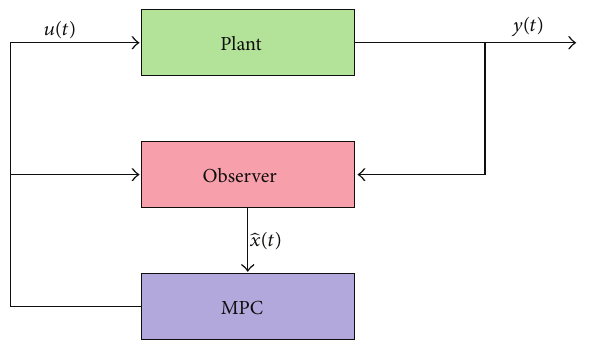
Figure 3: Block diagram of